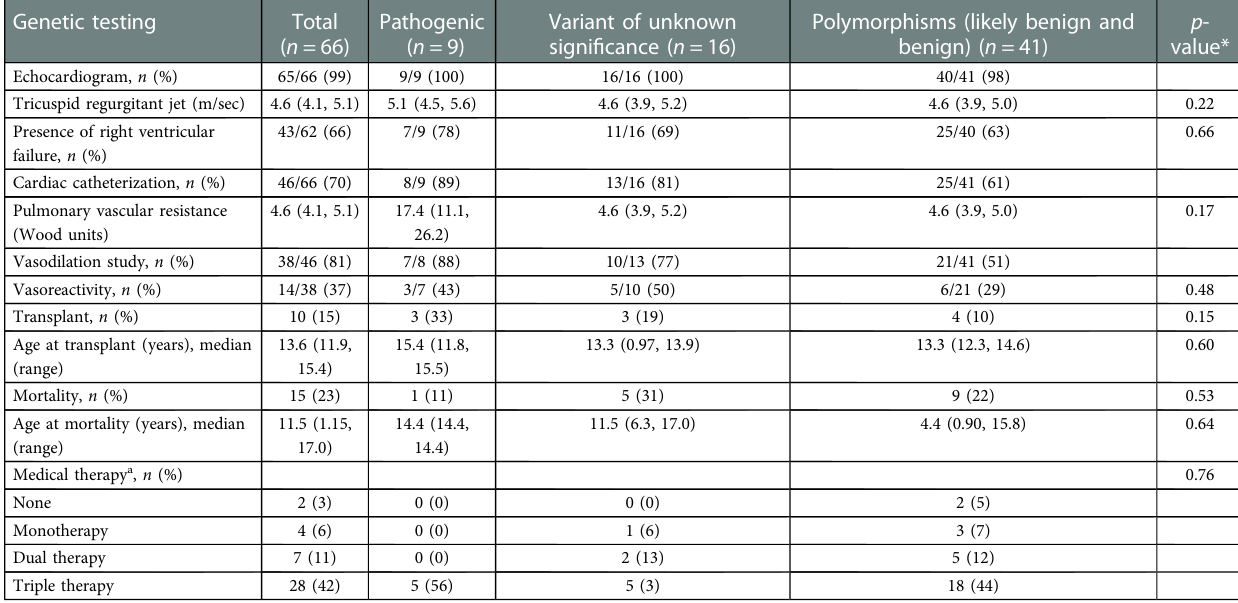
TABLE 3 Hemodynamic data and clinical outcome of patients by genetic testing results. Genetic